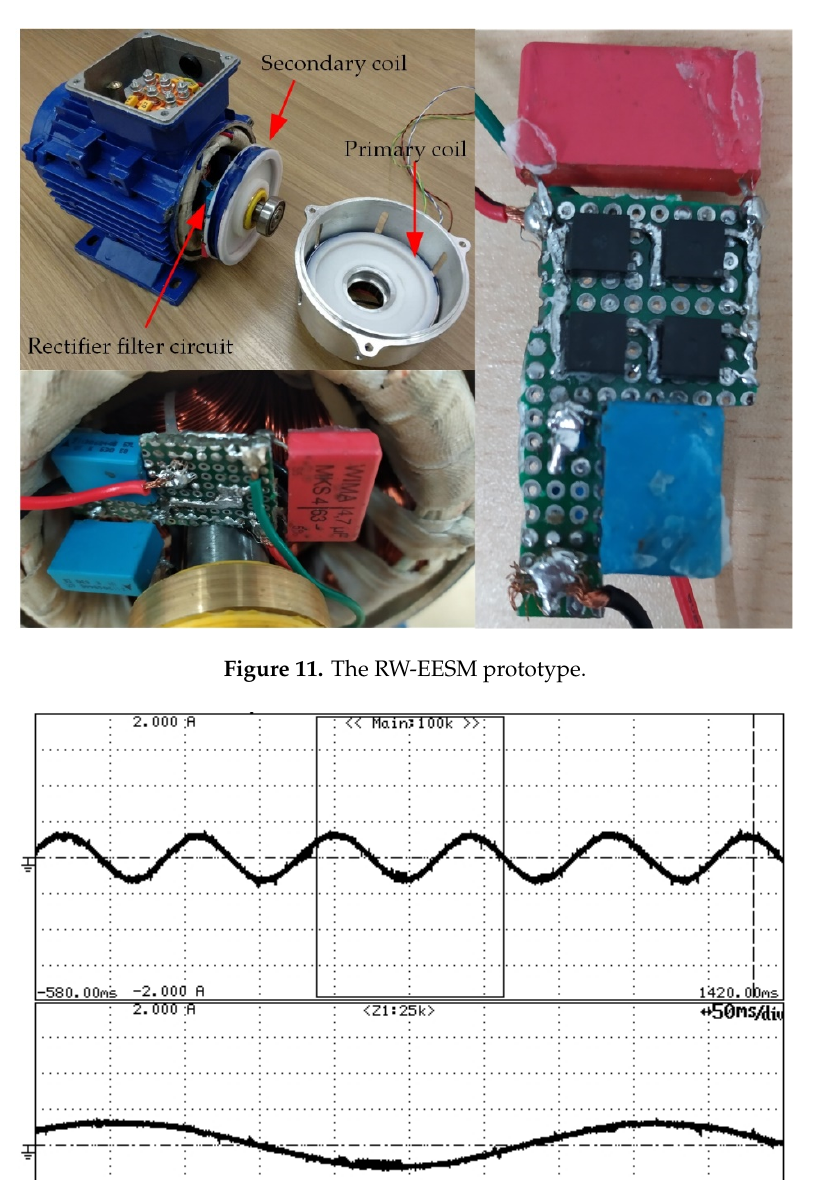
Figure 12. Phase current of RW-EESM